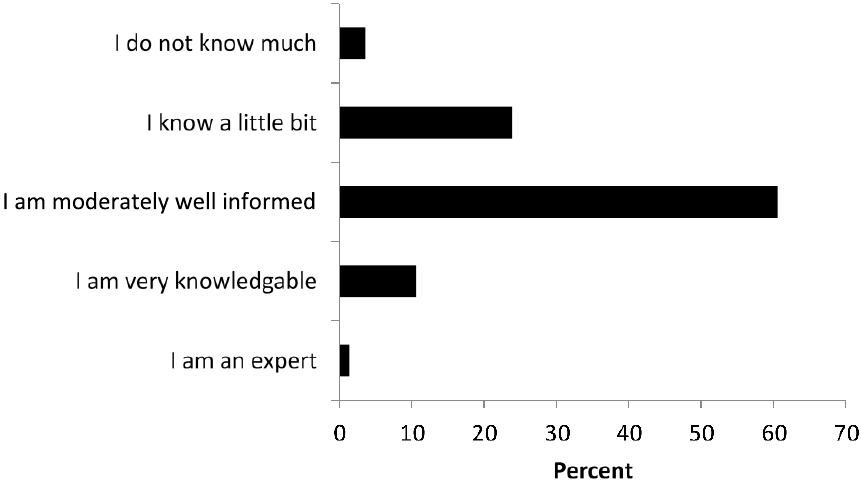
Figure 1. Resopndents self-assessed level of knowledge about climate change.